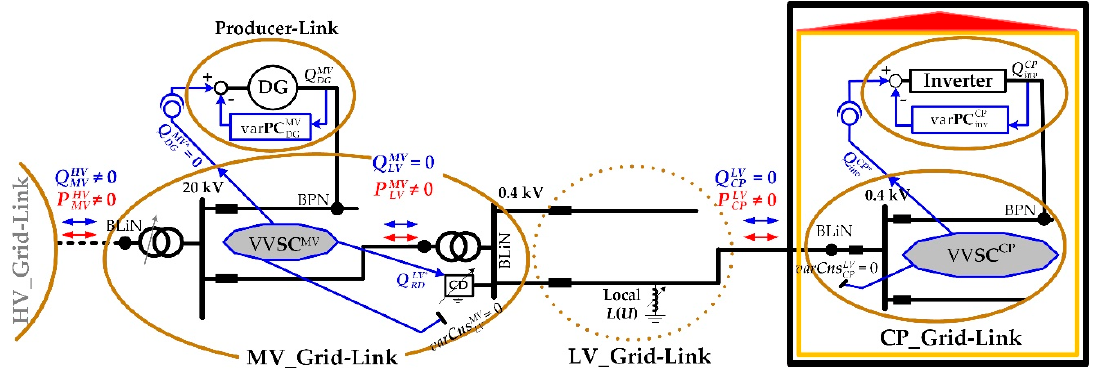
Figure 9. Simplified form of the VVC chain strategy representing the setup with L ( U )-control, CP_ Q -autarky and CDs at the DTRs’ LV-busbars.